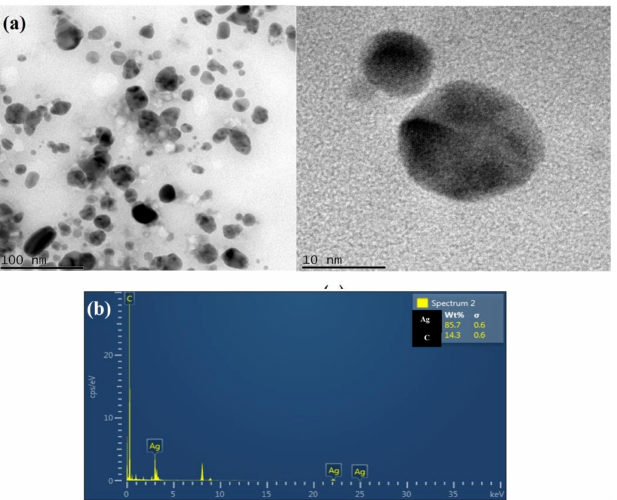
Figure 7. ( a ) Transmission electron microscopic examination of bacterial supernatant-synthesized silver nanoparticles shows the nano size (14 ± 4.7 nm) with sphere-shaped AgNPs synthesized from probiotics L. plantarum . ( b ) Energy-dispersive X-ray (EDX) spectrum of synthesized nanoparticle confirms the presence 85.7% of Silver